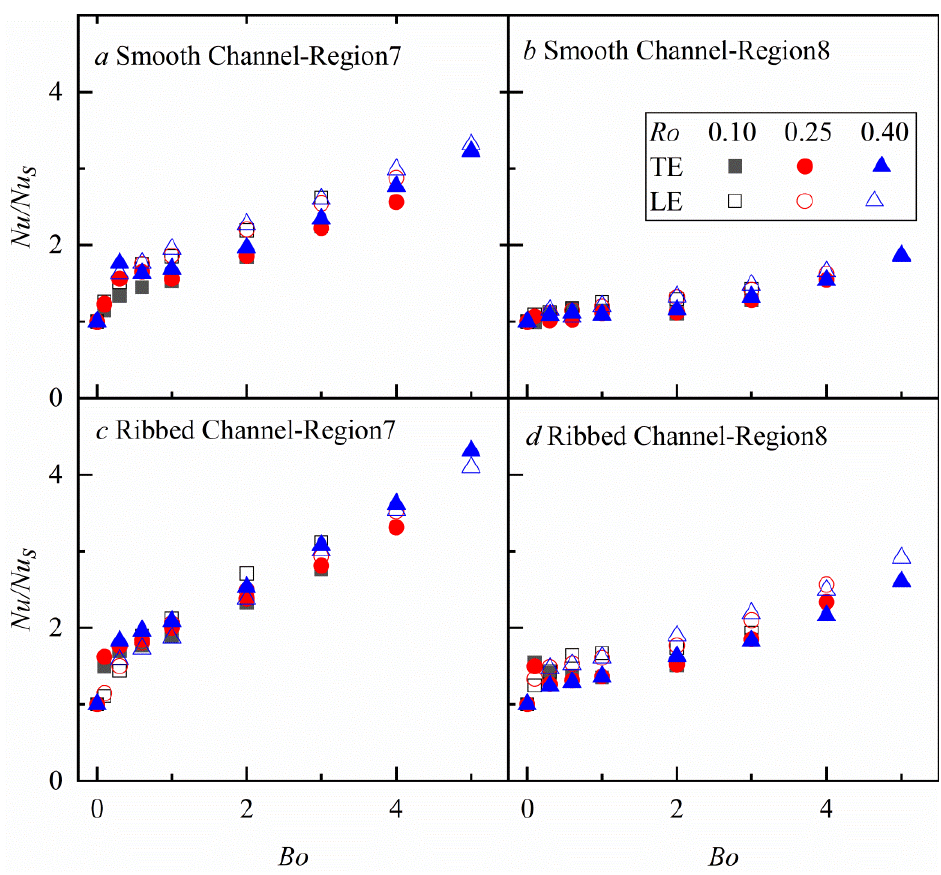
Figure 17. Nu / Nu s – Bo in the tip turn (regions 7 and 8).